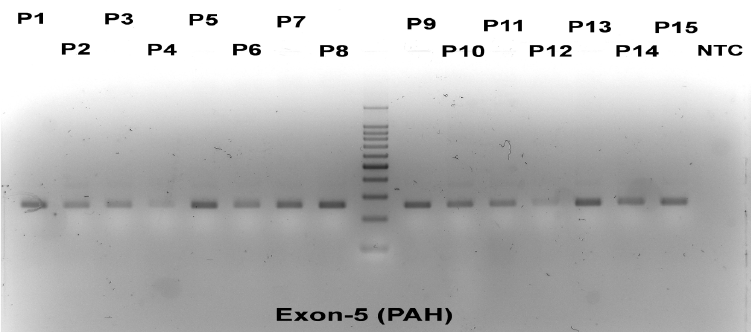
Figure 1. Results of electrophoresis of amplified fragments of 15 patient samples (258 bp) on 1% agarose gel, 100 bp marker size, non-template control( NTC).